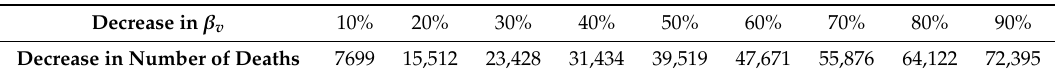
Table 2. Relationship between the decrease in β v and the resultant number of deaths avoided when this decrease is applied from the beginning of the outbreak expressed as the mean value of the Monte Carlo